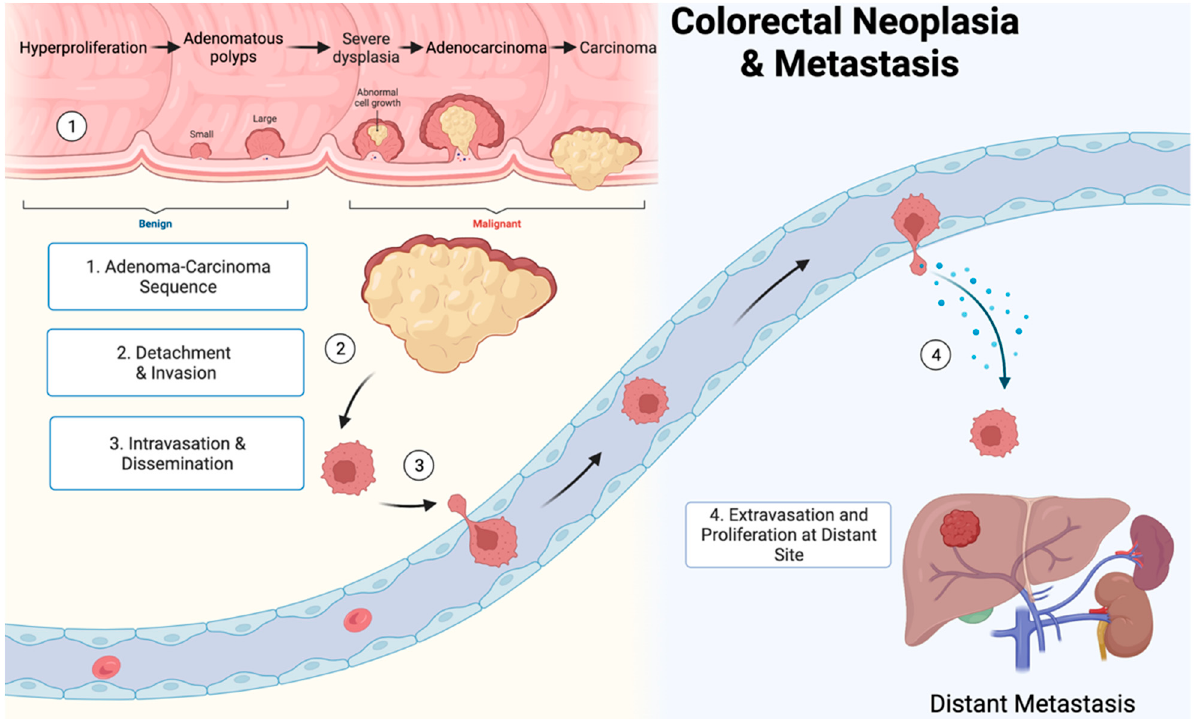
Figure 3. The metastatic cascade is a stepwise process involving carcinogenesis, detachment, and invasion, intravasation and dissemination, and extravasation and proliferation at a distant site. Figure created using biorender.